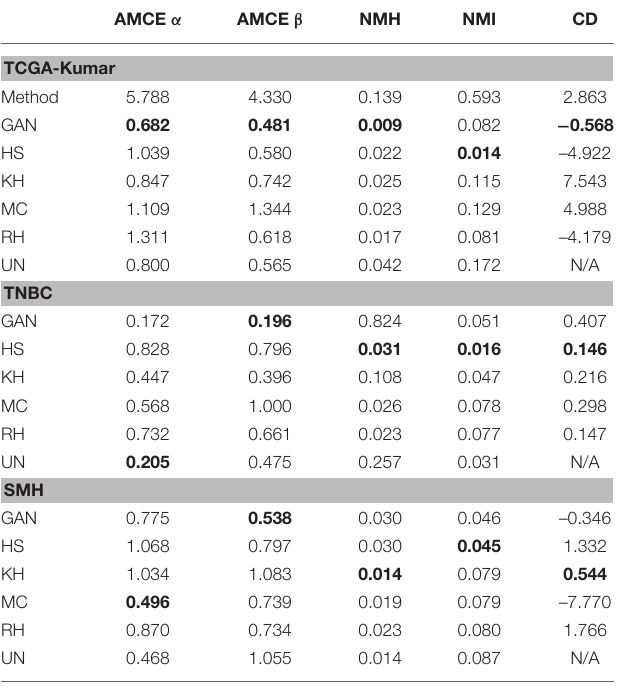
TABLE 2 | Coefficient of variation for un-normalized and color normalized datasets. AMCE α